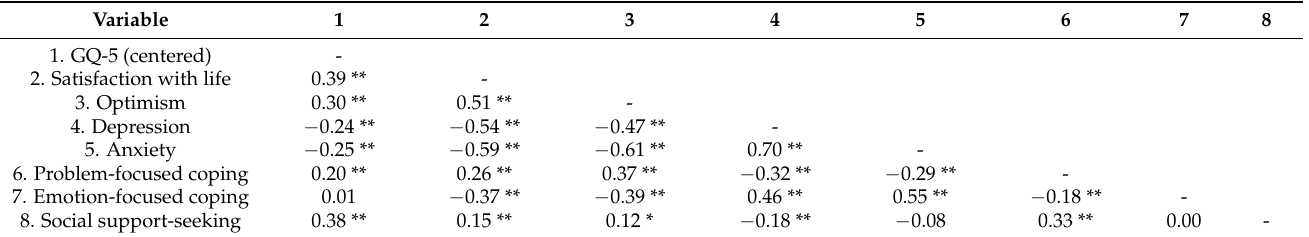
Table 2. Pearson’s correlations between GQ-5 and indicators and determinants of mental health and well-being. Variable 1. GQ-5